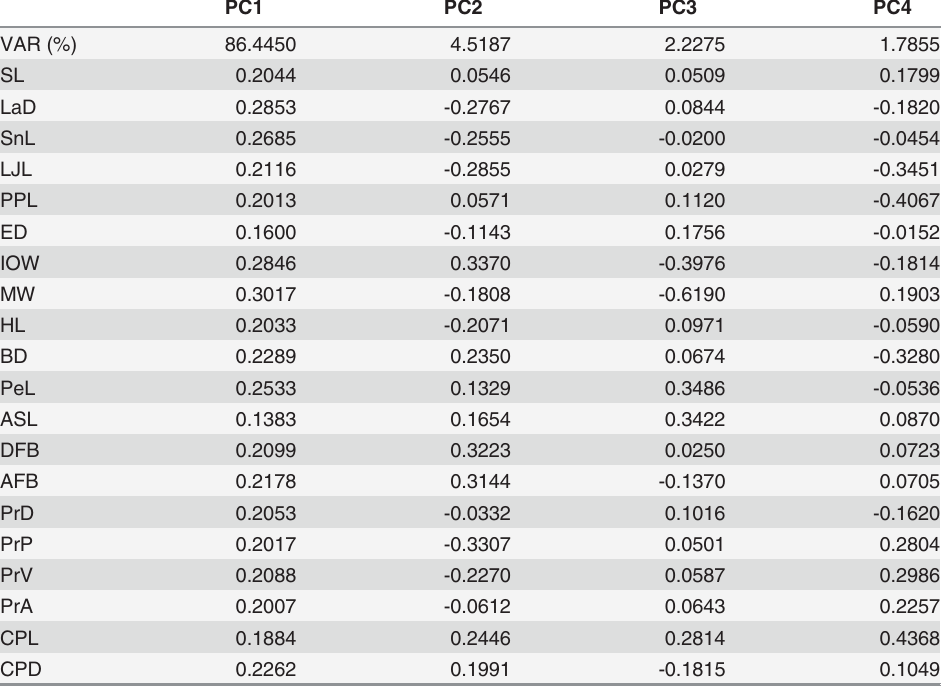
Loadings and explained variance of the fi rst four PC of a PCA conducted on the covariance matrix of 20 log-transformed measurements taken on 60